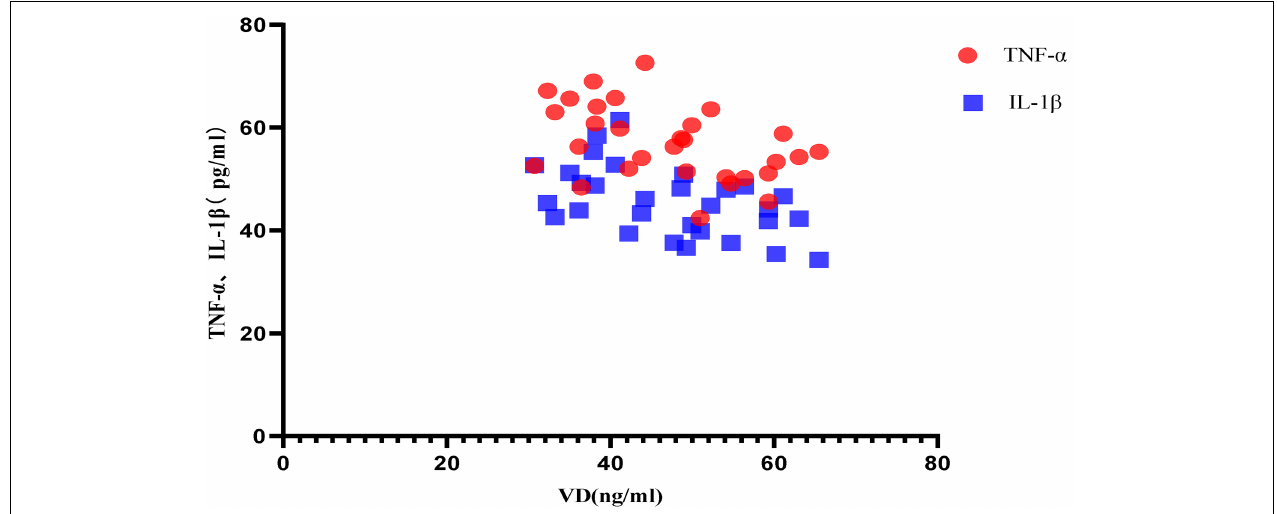
FIGURE 7 | Scatter plot of correlation analysis between VD and inflammatory